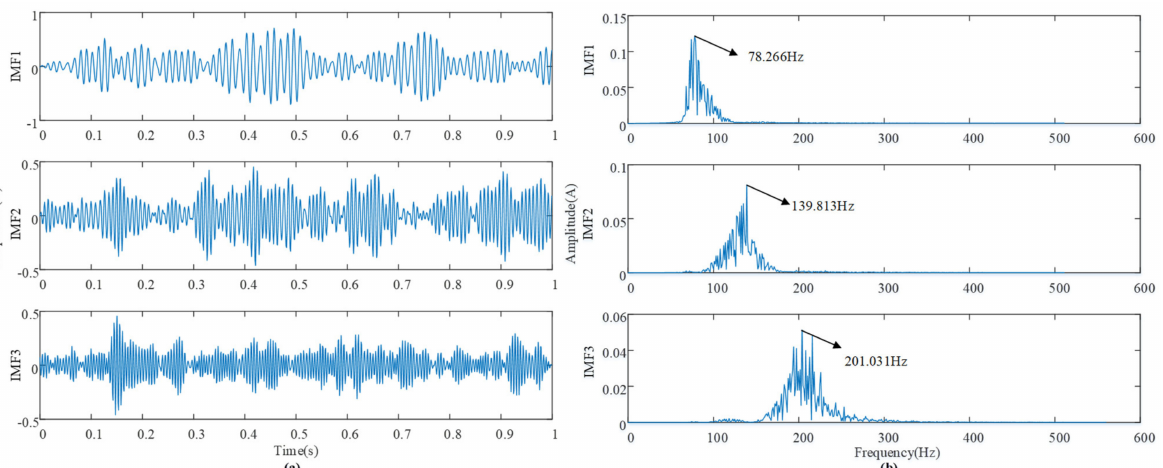
Figure 22. IMF components of compound faults after the first ACSRS − VMD: ( a ) Time − domain; ( b ) frequency domain.